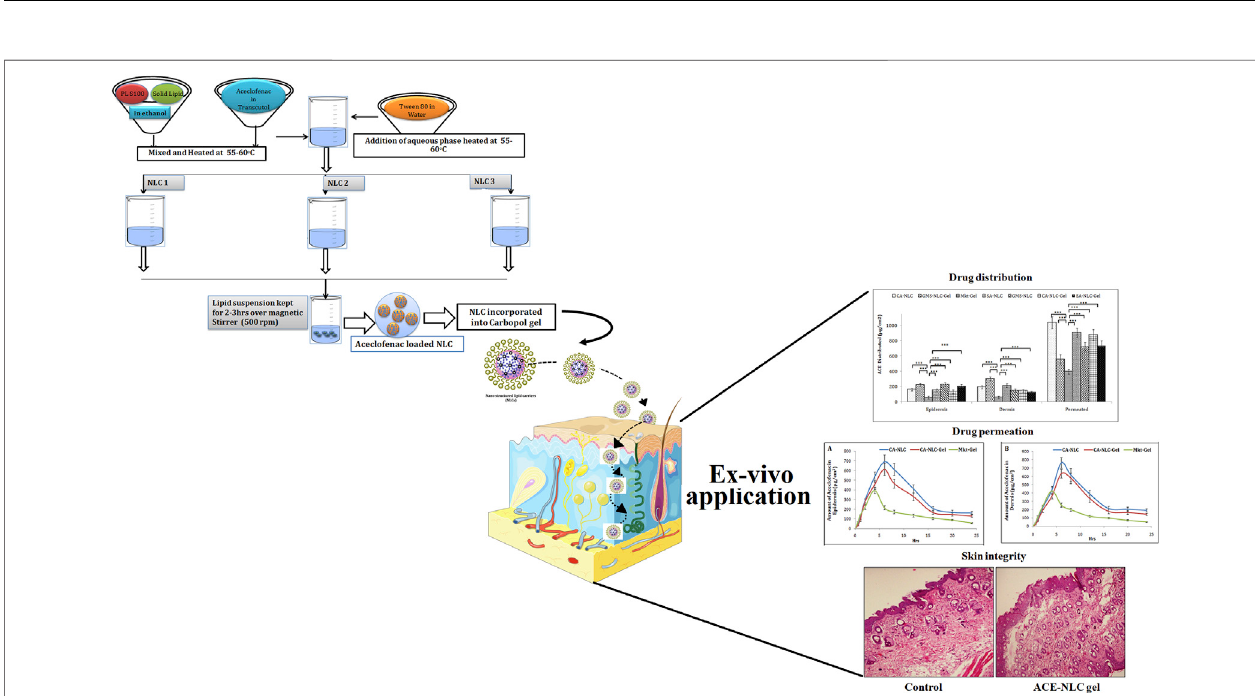
FIGURE 1 | Phase diagram of NLCs prepared using different